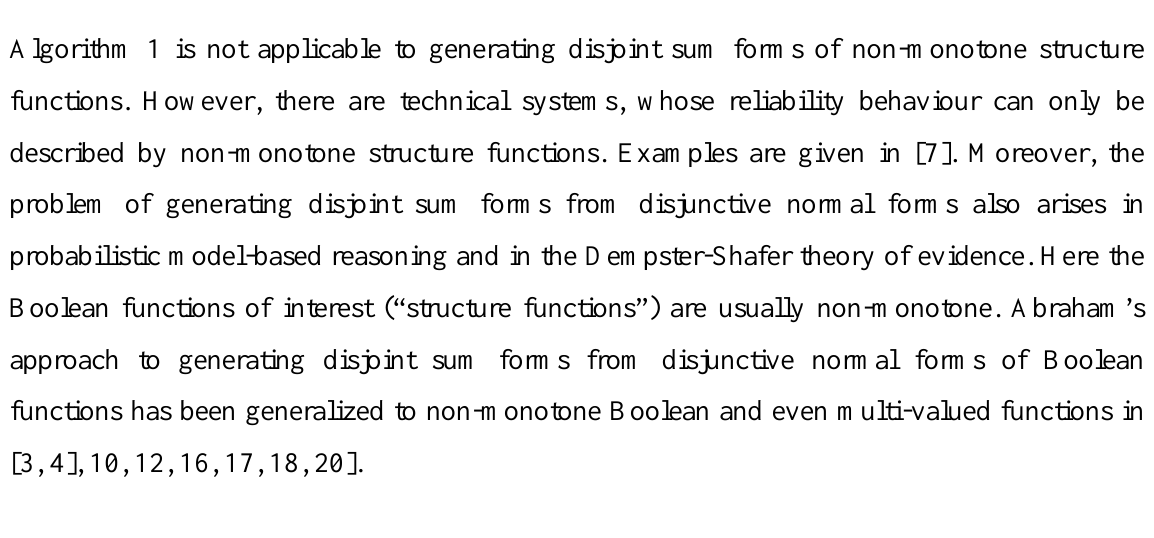
Algorithm 1 is not applicable to generating disjoint sum forms of non-monotone